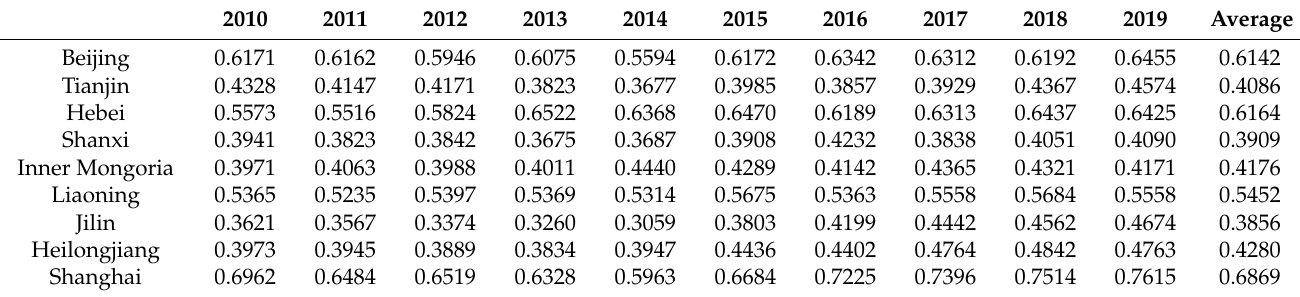
Table 4. Coupling degree of 31 regions from 2010 to 2019 (actual